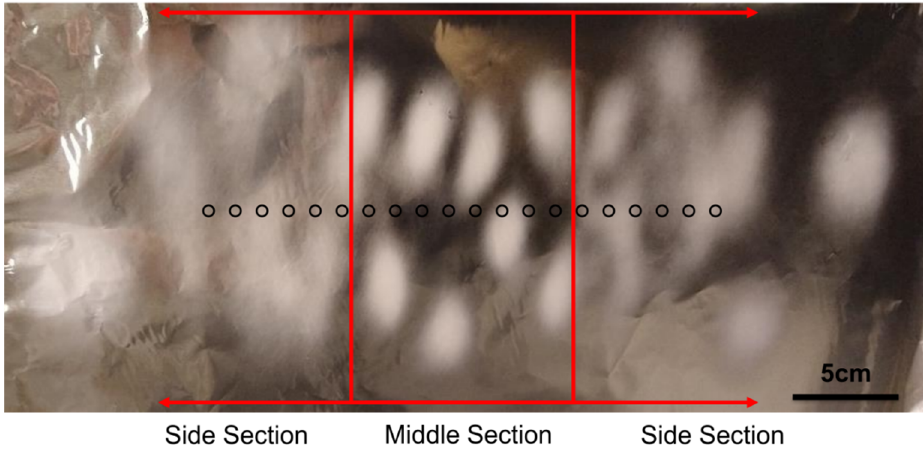
Figure 2. Deposition pattern of the initial setup (without auxiliary electrodes). The black circles represent needle position.